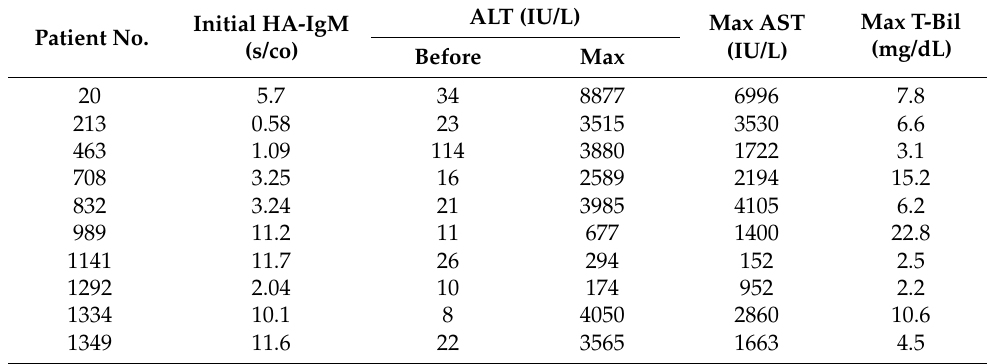
Table 3. Laboratory data associated with hepatitis